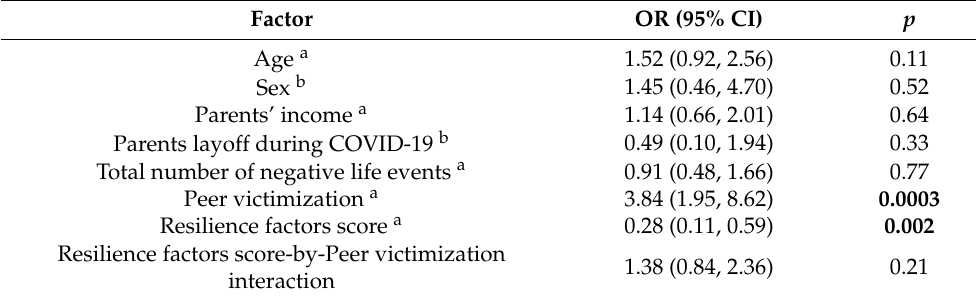
Table 2. Multivariate logistic regression with ASQ ≥ 1 as dependent variable.